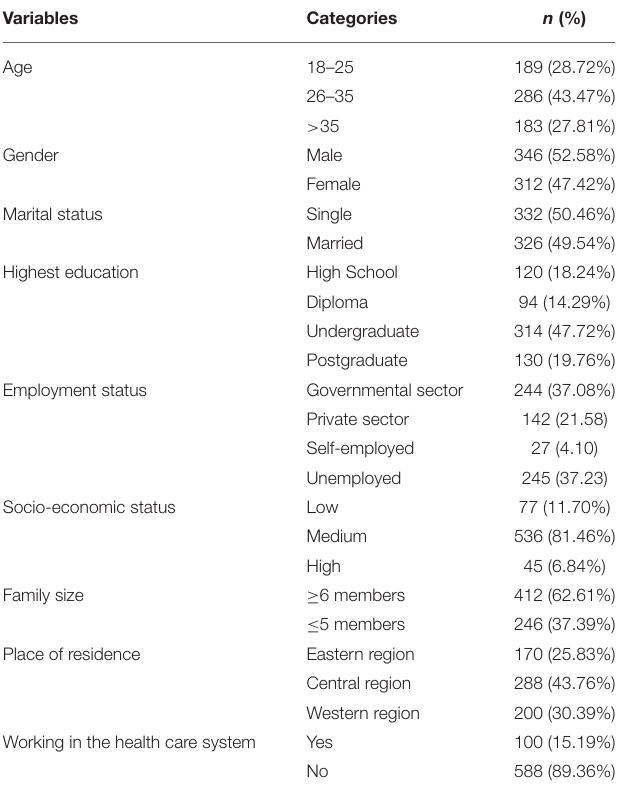
TABLE 1 | Socio-demographic characteristics of the study respondents ( N =